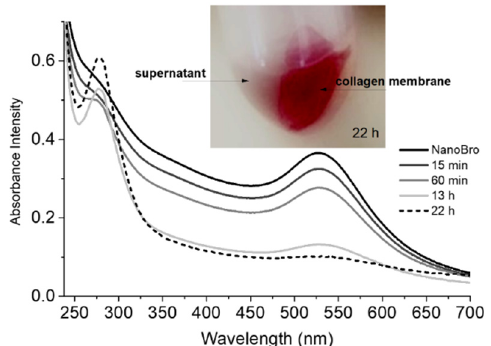
Figure 4. Binding affinity and proteolytic activity of NanoBro on Type I collagen membranes. UV-Vis spectra of progres- sive bleaching of NanoBro colloidal suspension during 22 h of incubation with Type I collagen membrane with concomi- tant increasing of the absorbance of peptide chains. NanoBro colloidal suspension (black line) was incubated with the collagen membrane and the spectra of the supernatant was collected and analyzed by UV-vis spectroscopy after 15 min (dark grey line), 1 h (grey line), 13 h (light grey line), and 22 h (black dotted line). Peak at 280 nm is a contribution of peptide fragments leached from the membrane and absorbance peaking at 520 nm is the contribution of NanoBro SPR band. The inset shows collagen membrane red colored by the adsorption of NanoBros after 22 h of incubation.